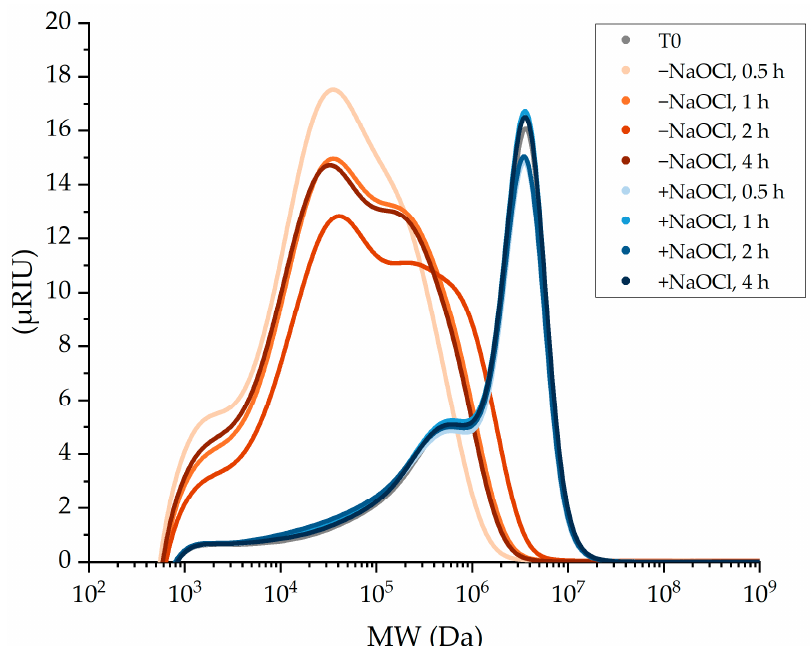
Figure 1. Molecular weight distribution of 15% raw potato starch treated with 11 µg mL − 1 (~190 nM) Bl- α Amy for 0.5–4 h. Grey chromatogram (T0): native washed potato starch. Orange chromatograms ( − NaOCl): samples inactivated by multistep washing only. Blue chromatograms (+NaOCl): samples inactivated with NaOCl (7 mM) before multistep washing.